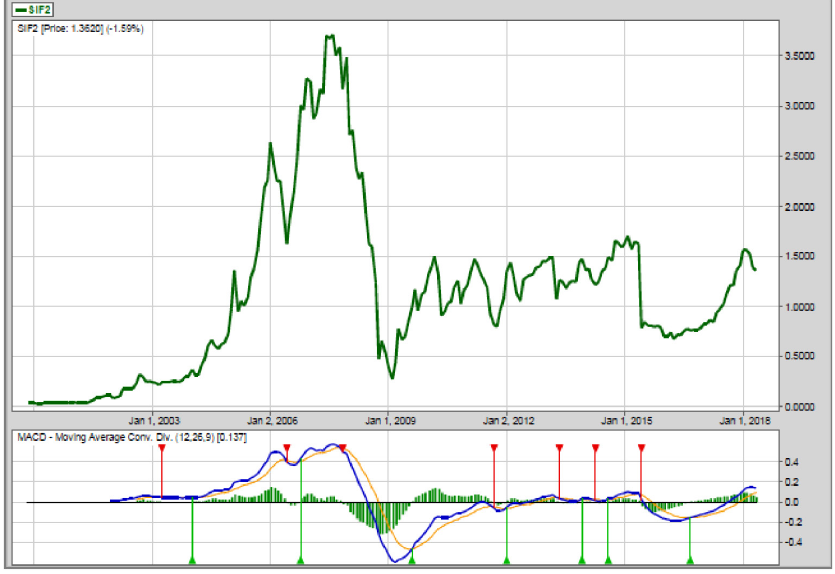
Figure 9. MACD applied to SIF2 (source: own processing based on the data available on ifbf Finwest,